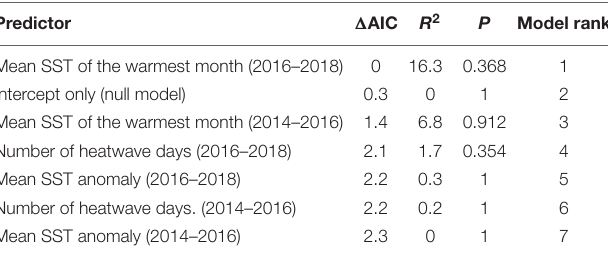
TABLE 2 | Summary of model comparisons evaluating the relationship between giant kelp resilience and the three SST metrics during (July 2014 to June 2016) and after (July 2016 to June 2018) the